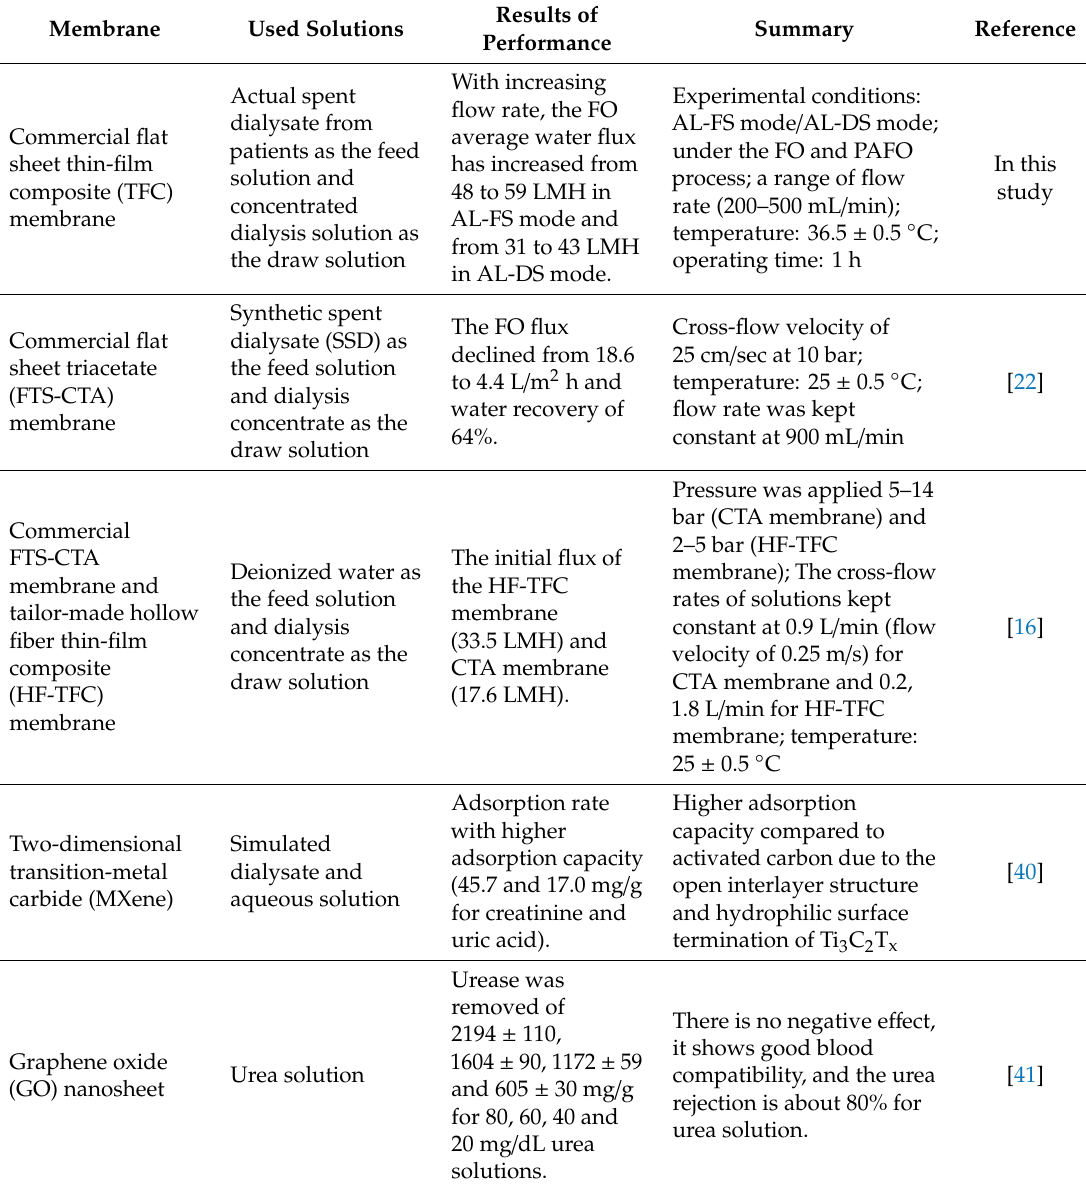
Table 2. Comparison of the performance of di ff erent methods for reuse of spent dialysate.